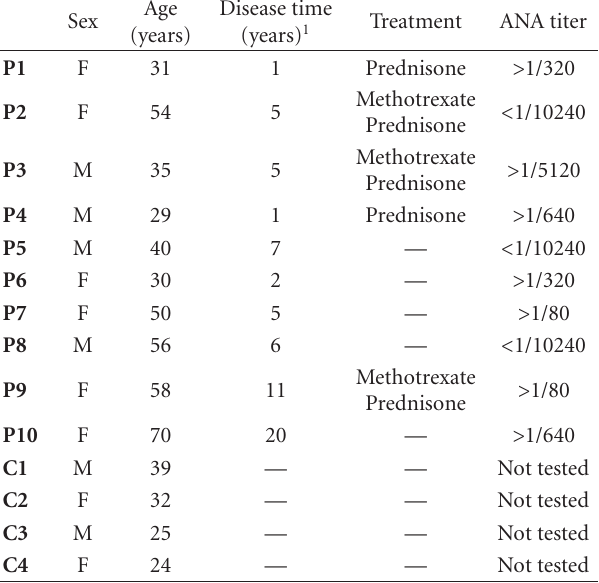
Table 1: Information about the subjects that consented to take part in this